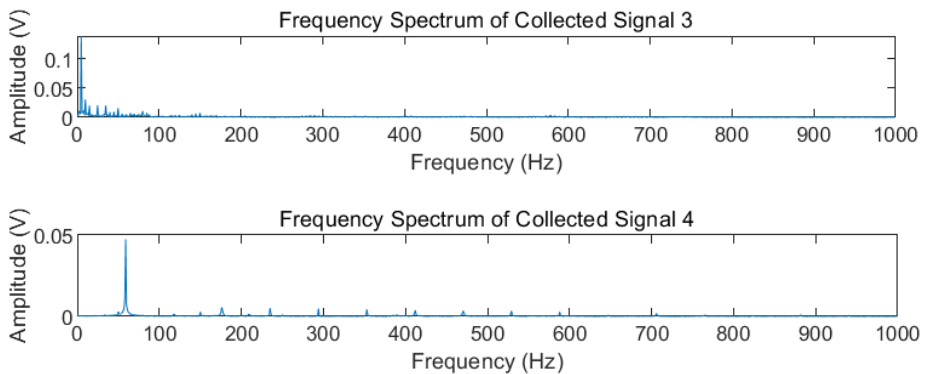
Figure 7. Frequency spectrum of Collected Signal 1 – 4.